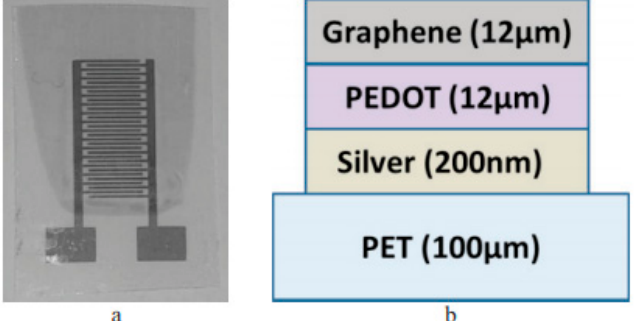
Figure 23. ( a ) Device dimensions: 1.8 cm by 1 cm with a thickness of about 140 μ m. IDT fingers: width (200 μ m), length (6 mm), thickness (200 nm), track spacing (350 μ m); ( b ) Schematic of the sensor structure PET: Polyethylene terephthalate. Reproduced with permission from Reference [117].